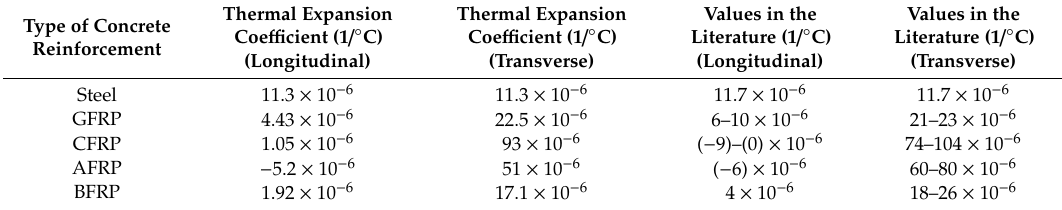
Table 1. Coe ffi cients for thermal expansion for selected materials used in concrete reinforcement